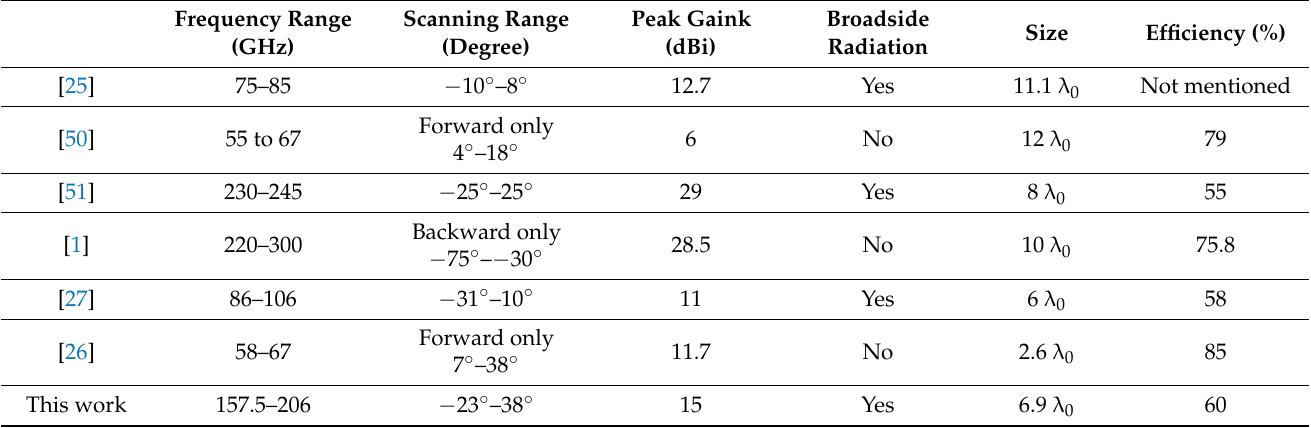
Table 1. Performance comparison with the prior